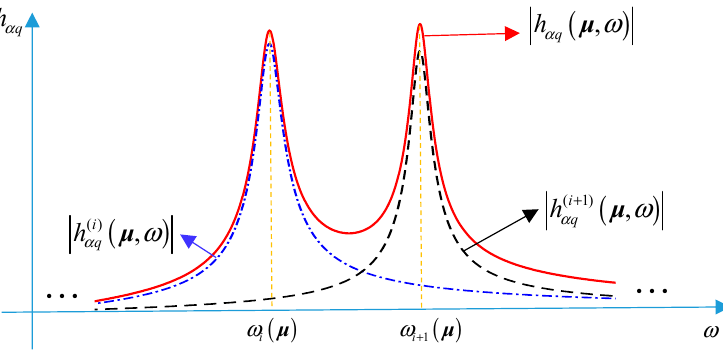
Figure 1. Summation of modal contributions into the frequency response.